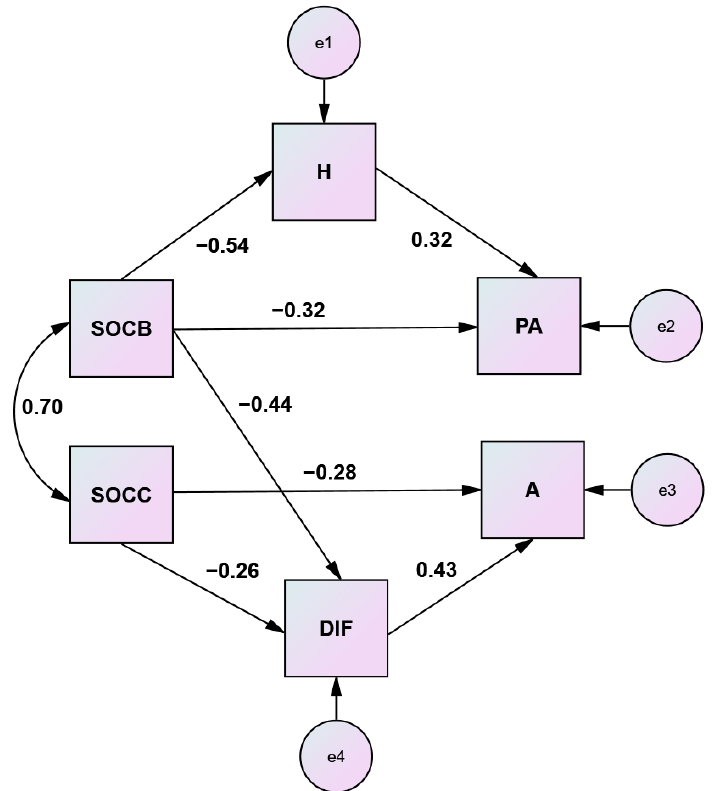
Figure 5. Path model illustrating patterns of effect within a system of research variables. Note: Standardized coefficients are presented.